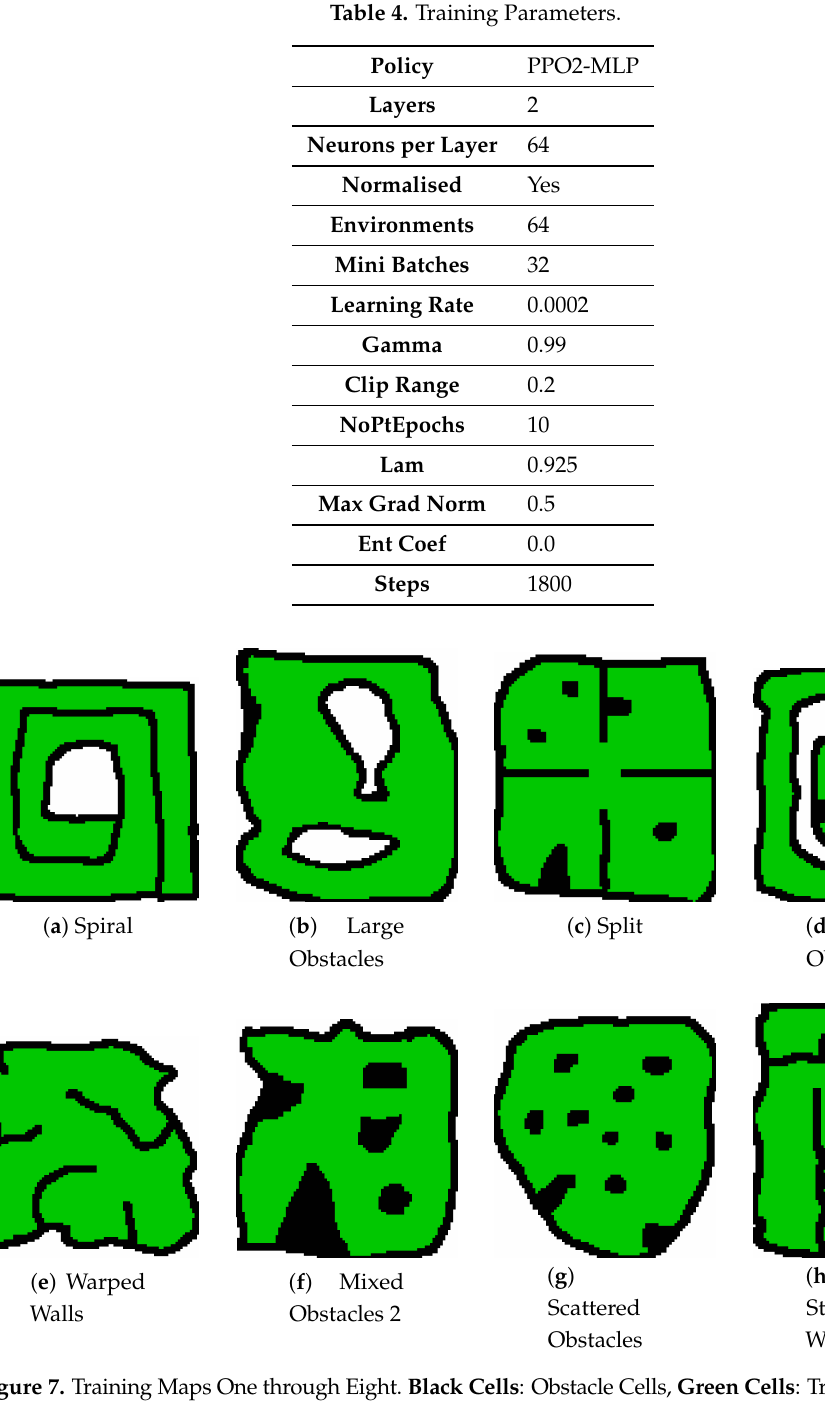
Figure 7. Training Maps One through Eight. Black Cells : Obstacle Cells, Green Cells : Traversable